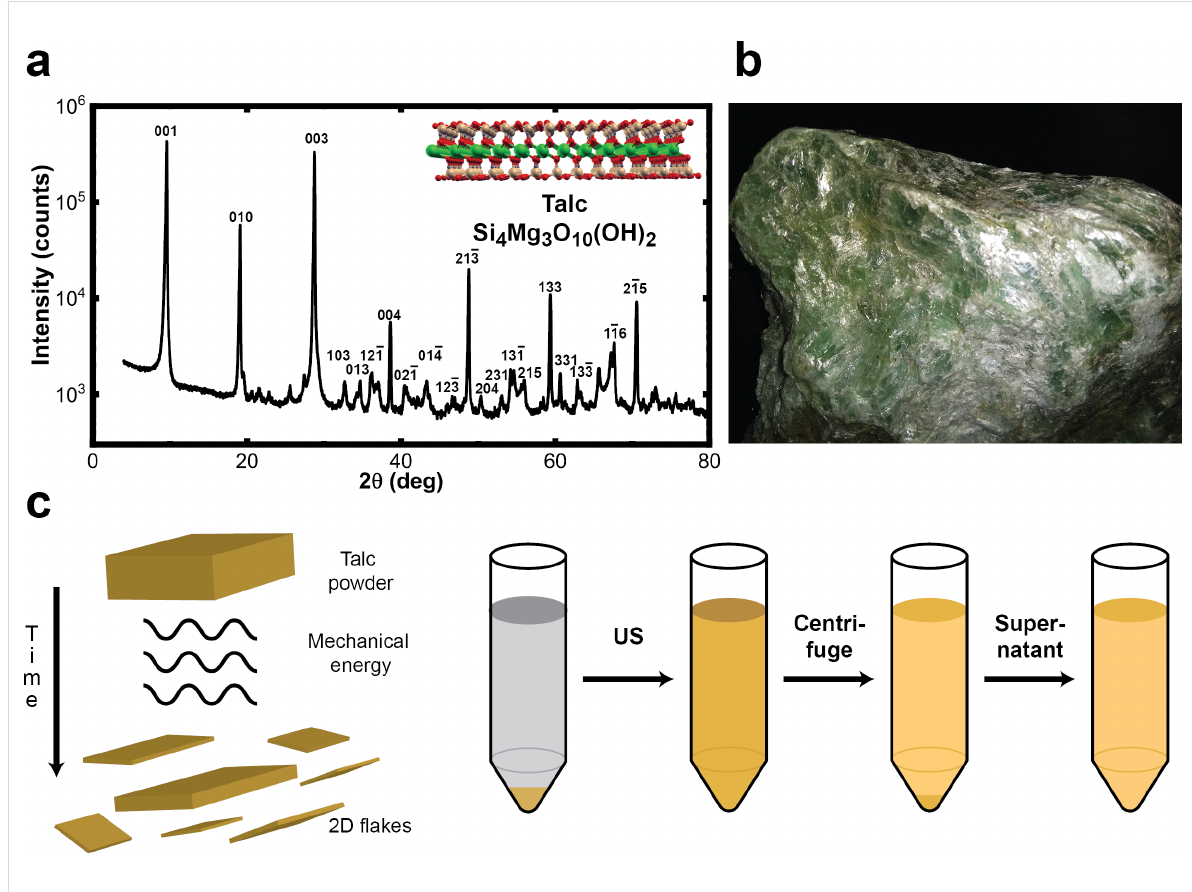
Figure 1: Talc characterization and exfoliation procedure. (a) XRD data for the sample employed here. The insert shows formula and structure of talc [12]. Pink, red, green, and gray circles represent Si, O, Mg, and H atoms, respectively. (b) Picture of the source mineral before being manually milled. It weighed approximately 1.3 kg. (c) Schematic representation of LPE. Micrometer-sized talc powder is exposed to mechanical energy, which leads to delamination of its layers. After exfoliation, the sample is centrifuged to separate non-exfoliated flakes from nanometer-sized flakes, and the super- natant is collected for further